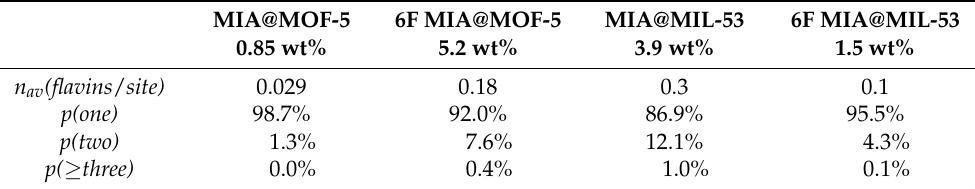
Table 2. Probability p that a certain occupation number of flavins per site is confined in MOFs assuming a random distribution of flavins a